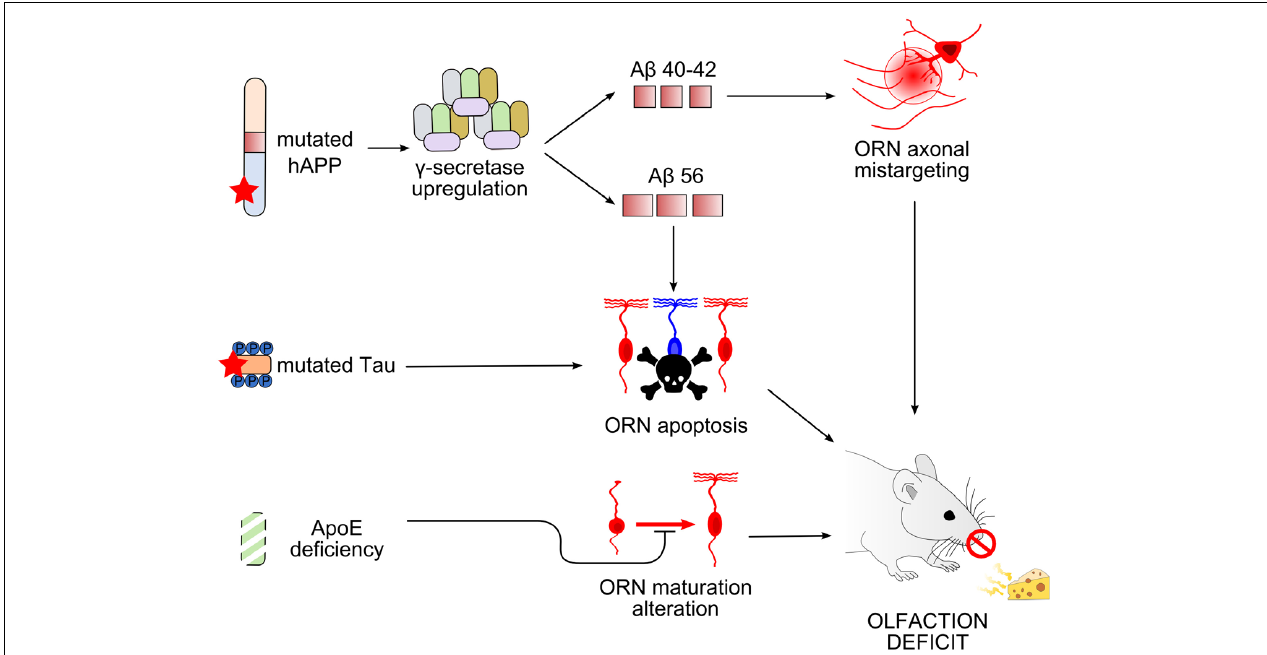
FIGURE 3 | Working models of olfactory deficit arising in the olfactory epithelium in mouse models of Alzheimer’s disease. Top, Overexpression of mutated human amyloid precursor protein (hAPP) induces an upregulation of γ -secretase complex, leading to the production of different types of A β peptides (Cheng et al., 2011, 2016; Kim et al., 2018). Amyloid- β 40/42 (A β 40 / 42 ) causes axonal mistargeting of olfactory receptor neurons (ORNs) in the olfactory bulb (OB) (Cao et al., 2012b), whereas A β 56 causes ORN apoptosis (Kim et al., 2018). Middle, Mutation of tau also causes ORN apoptosis. Bottom, Apolipoprotein E deficiency alters the maturation of ORNs. All these alterations lead to deficits in olfactory-driven behaviors (Nathan et al., 2010; Zhang et al.,